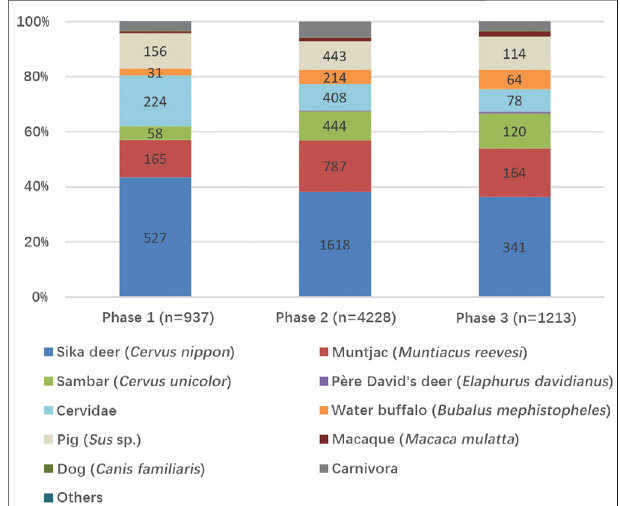
FIGURE 3 | Mammal species and relative proportions of